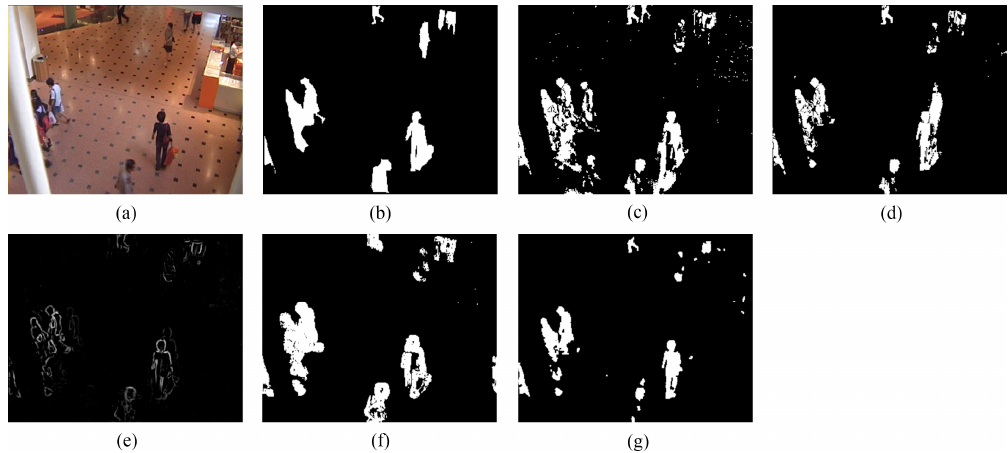
Figure 6. Detection results of the eighth frame of SC96 (Frame 1827): ( a ) input frame; ( b ) ground-truth reference; ( c ) result of the visual background extractor (ViBe); ( d ) result of principal component pursuit (PCP); ( e ) result of the transform domain method based on 2D DFT (TD-2DDFT); ( f ) result of the transform domain method based on 2D undecimated wavelet transform (UWT) (TD-2DUWT); ( g ) result of the transform domain method based on 3D DWT (TD-3DDWT). Sensors 2016 , 16 , 456